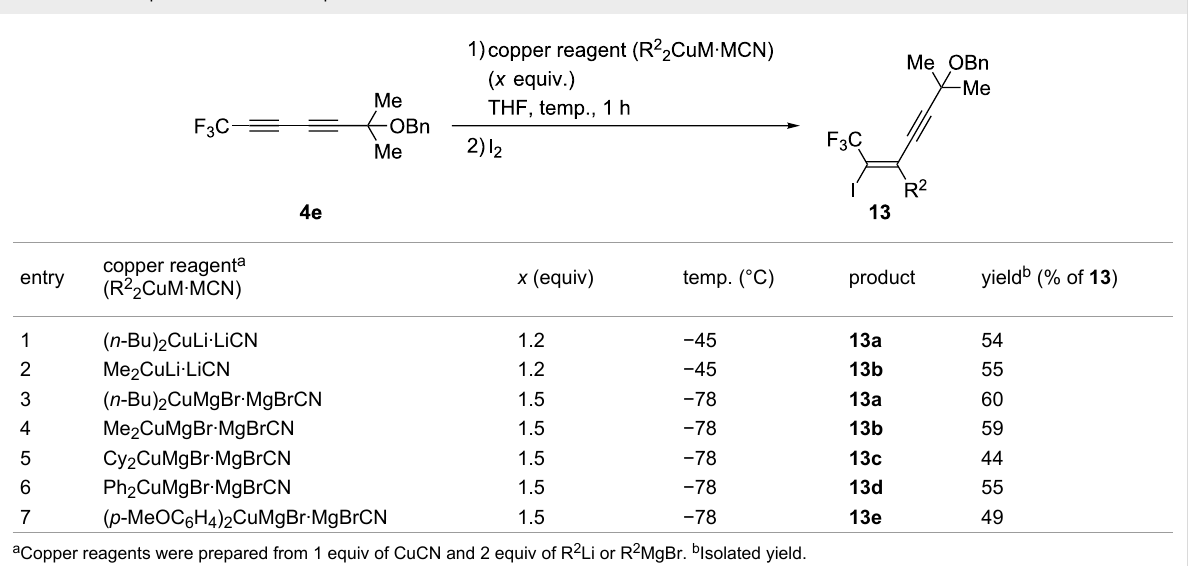
Table 4: Carbocupration with various cuprates.